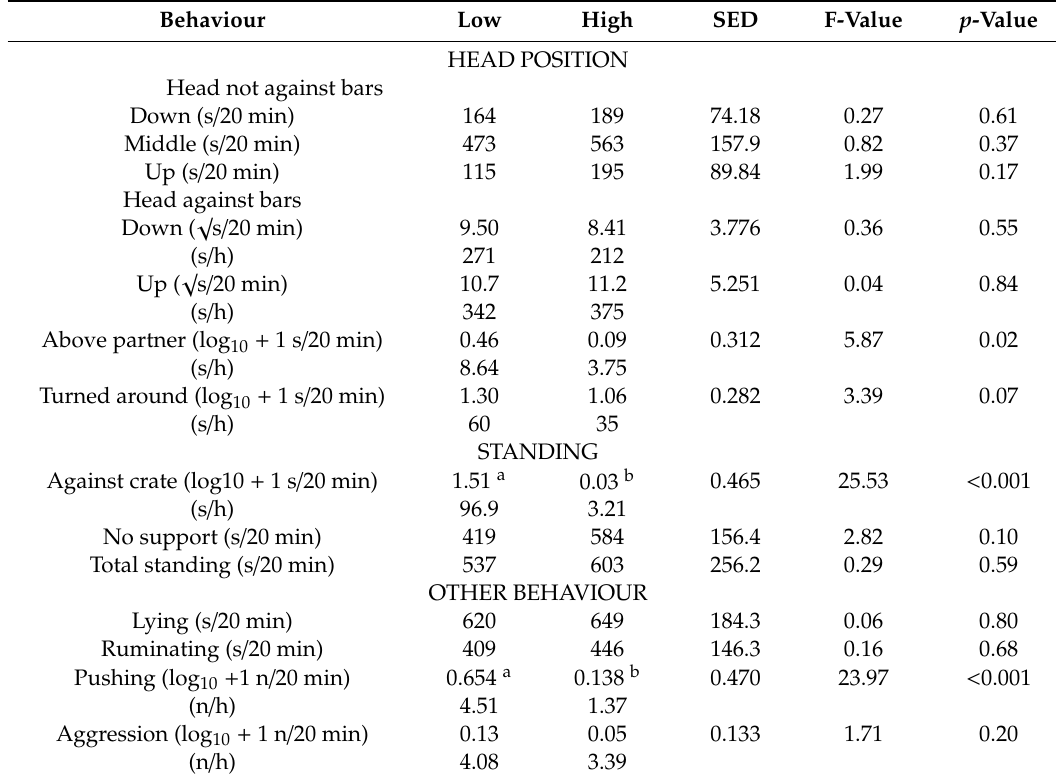
Table 1. E ff ects of Low and High space allowance treatments on the behaviour of sheep during simulated sea conditions.